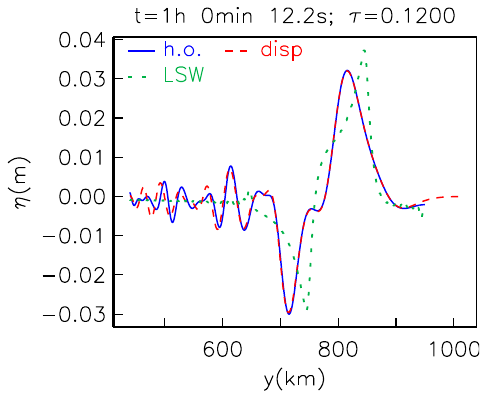
Fig. 8. The linear hydrostatic and linear dispersive solutions of the Indian Ocean tsunami towards Africa extracted along a transect with length 1000km (surface elevations). Waves are propagating to the left. Fig. 6. The surface elevation along the x = 0 transect. Waves are